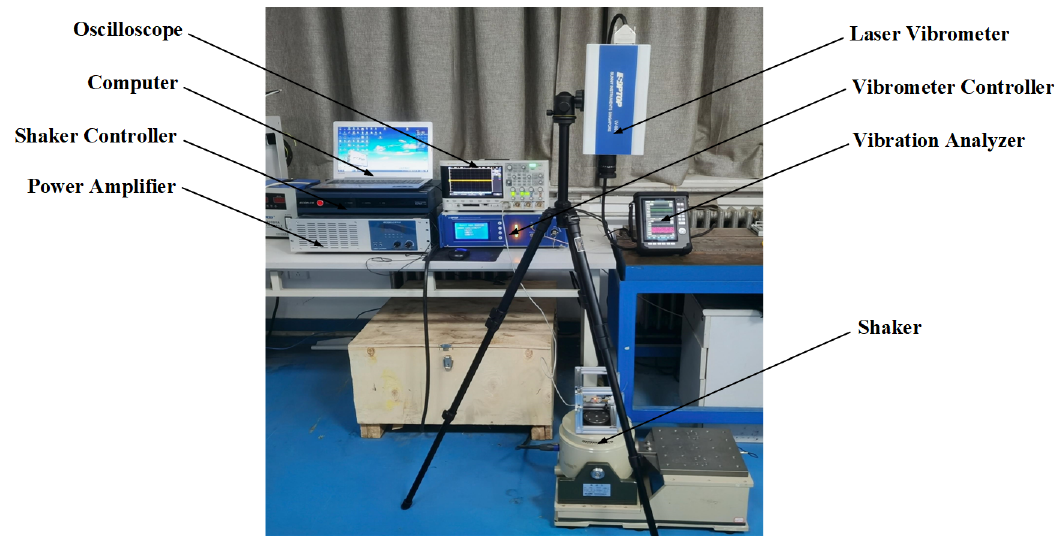
Figure 13. Experiment testing system.